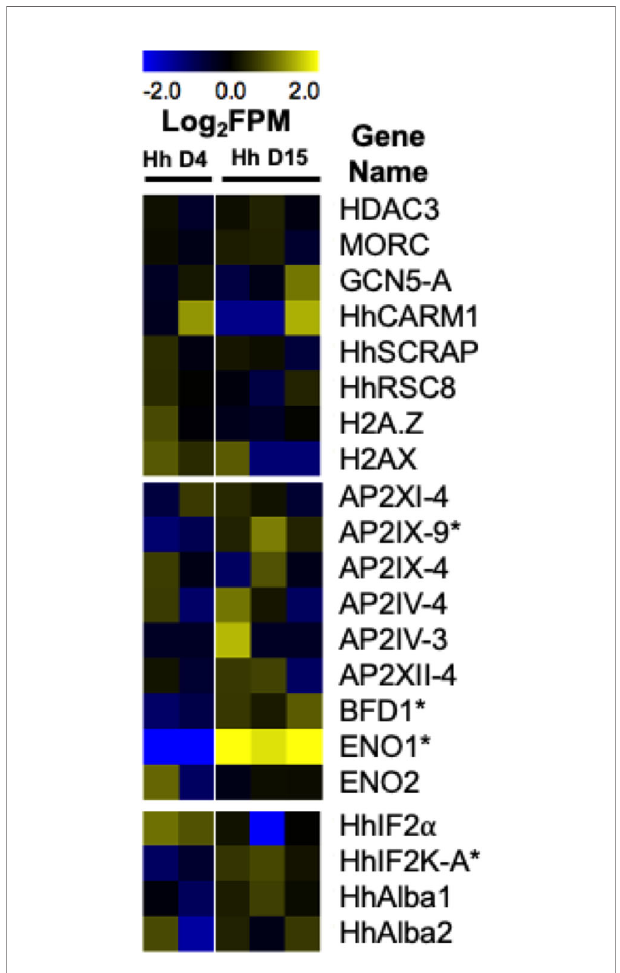
FIGURE 3 | Heatmap representing H. hammondi transcriptional abundance during spontaneous development of known regulators of bradyzoite formation. Heatmaps show mean centered Log 2 FPM values. Asterisk (*) represent genes with signi fi cant differences between D4 (N = 2 biological replicates) and D15 (N = 3 biological replicates) samples. Signi fi cance is de fi ned as |Log 2 Fold Change| >1 and P adj < 0.01. T. gondii gene IDs for these genes and the gene IDs for each orthologs in H. hammondi and N. caninum are found in Table 2 . The H. hammond i transcriptional data used to generate this fi gure was obtained from (Sokol et al.,